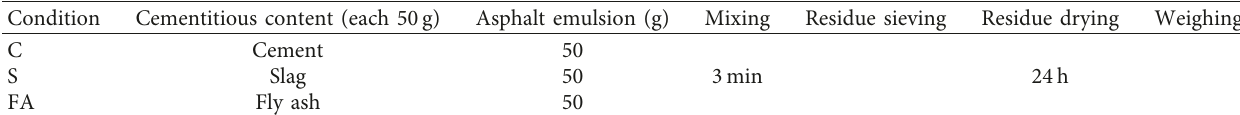
Figure 1: Mixing stability test (a) and UCS test (b). Table 4: Mix design for a new mixing stability